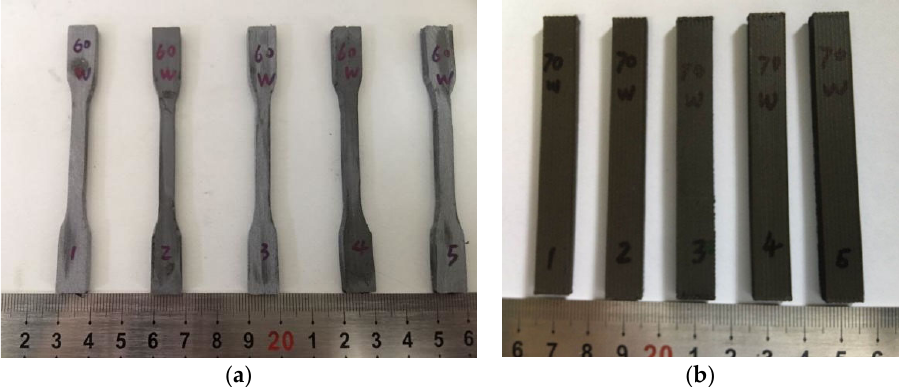
Figure 7. FDM 3D printed test pieces used for mechanical properties testing: ( a ) tensile strength and ( b ) test pieces for flexural strength.